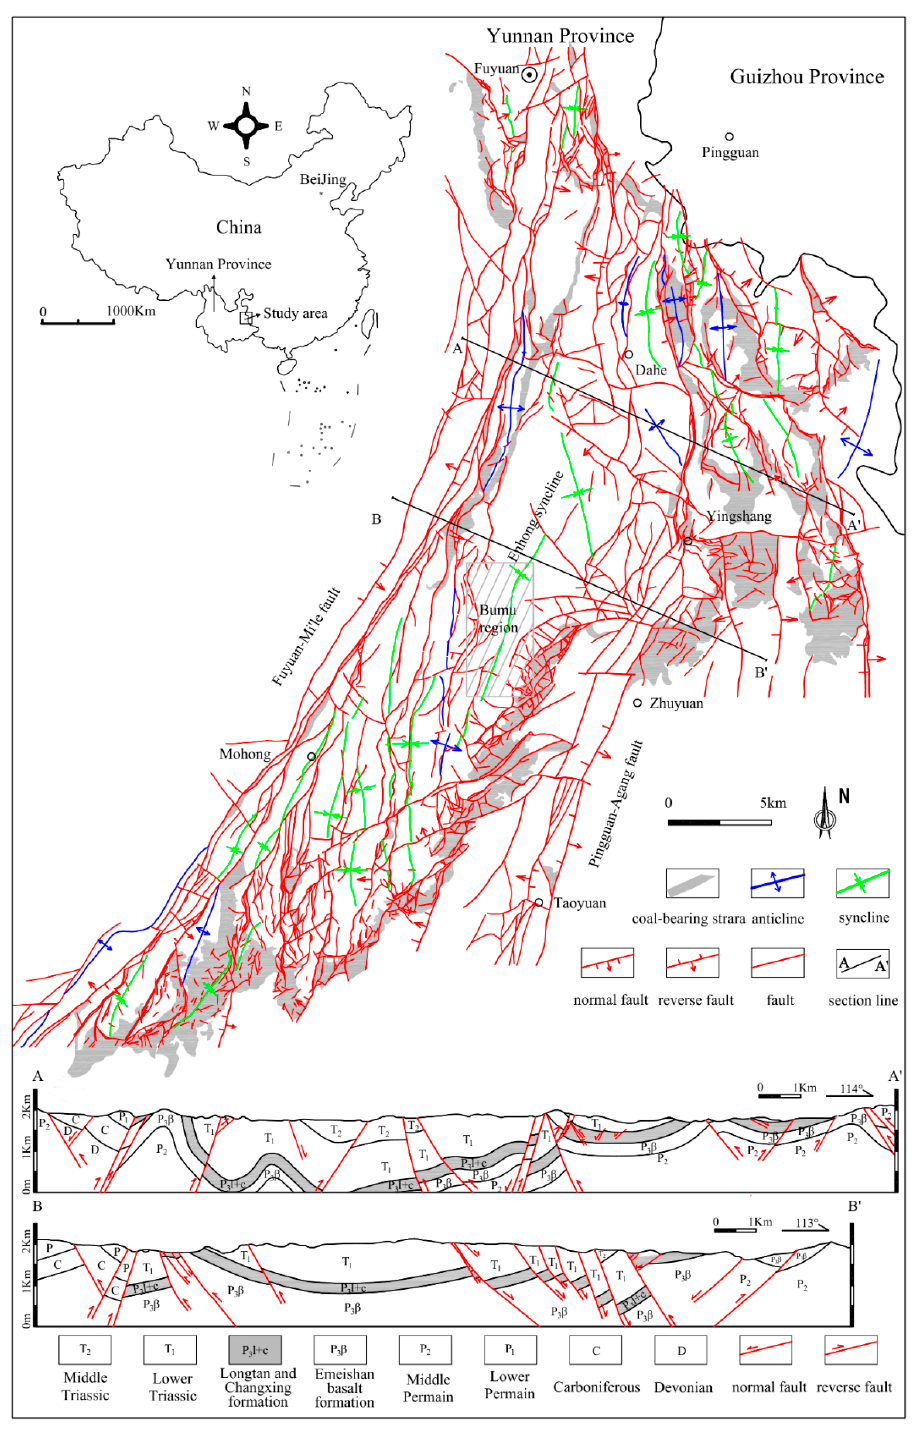
Figure 2. Geological sketch map and structural cross section of Enhong synclinorium.